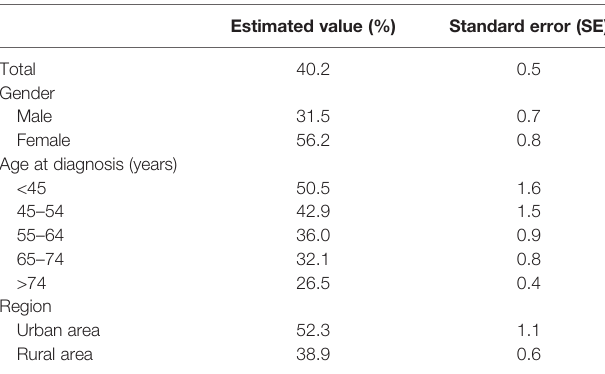
TABLE 3 | Survival of lung cancer patients in four cancer registries in Taizhou City from 2014 to 2018. Estimated value (%)